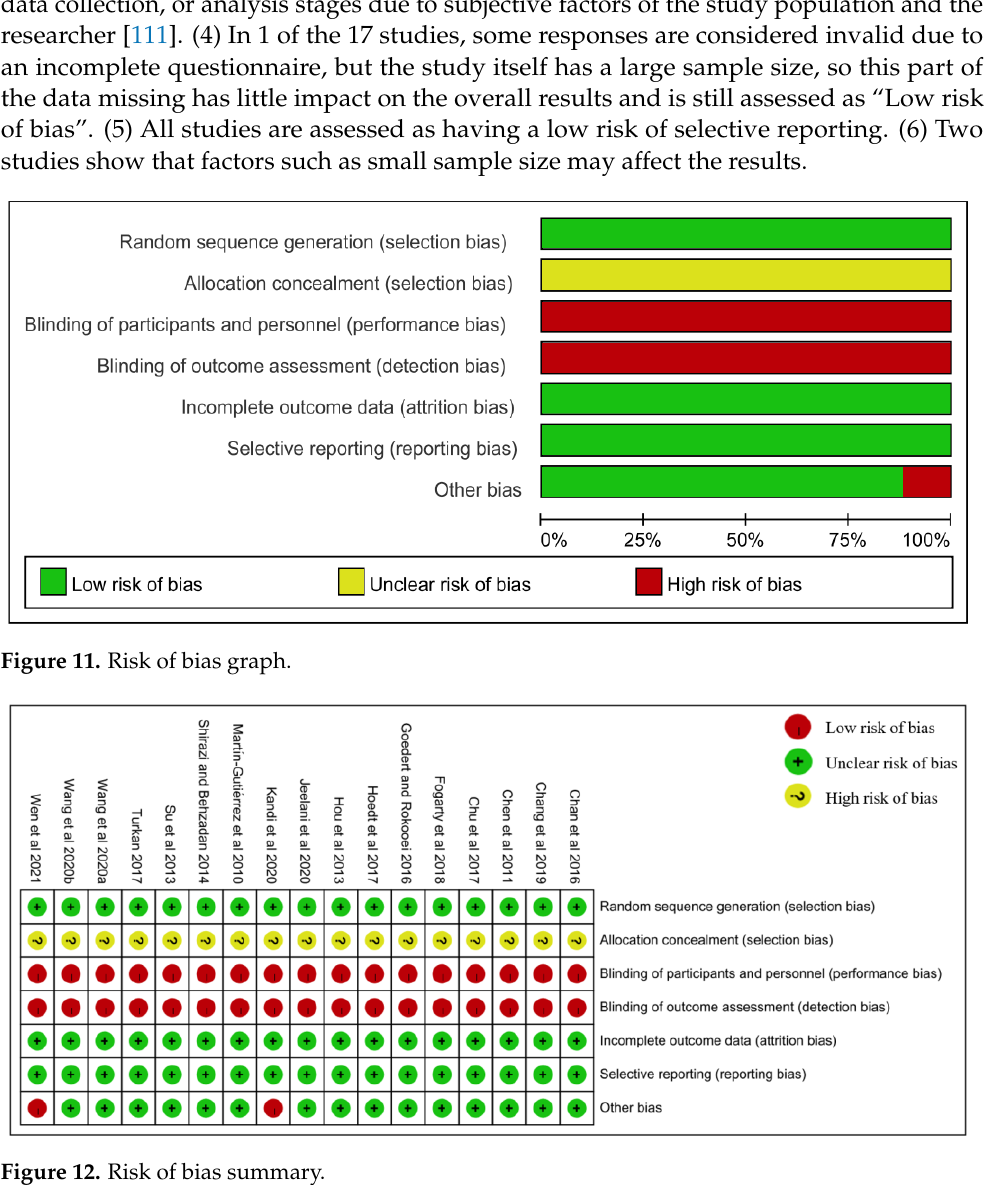
Figure 12. Risk of bias summary.